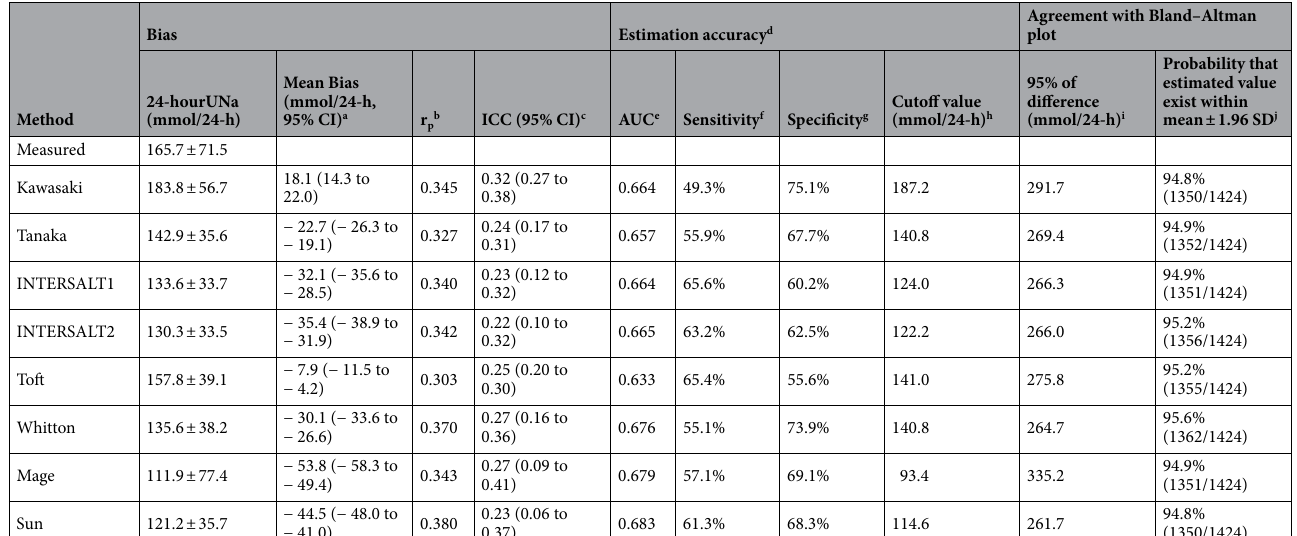
Table 3. Comparison between measured and estimated sodium excretion using eight formulas for 24-hUNa excretion (n = 1424). 24-hUNa 24-h urinary sodium, r p Pearson correlation coefficient, ICC intraclass correlation coefficients, AUC area under the curve. a Mean bias all p < 0.001. b Person correlation all p < 0.001. c The values of single measures were used, and all p < 0.001. d The results of accuracy of prediction come from ROC curve. e Area under the ROC curve for predicting 24-hUNa in individuals whose sodium intake was ≥ 3000 mg/24-h (AUC), and the p value represents the significance value to refute the null hypothesis of being nondiscriminatory, and all p < 0.001. f The sensitivity is defined as the proportion of individuals whose measured 24-h urinary sodium ≥ 3000 mg with the estimated amount ≥ 3000 mg at the cutoff value. g The specificity is defined as the proportion of individuals whose measured 24-h urinary sodium < 3000 mg with the estimated amount < 3000 mg at the cutoff value. h The cutoff value is defined as the corresponding detection value at the maximum value of [sensitivity − (1 − specificity)]. i Ninety-five percent of the difference is the width between the upper limit and lower limit in the Bland–Altman plot. j The probability that the difference between the measured and estimated values existed within − 1.96 SD and + 1.96 SD of the mean value in the Bland–Altman